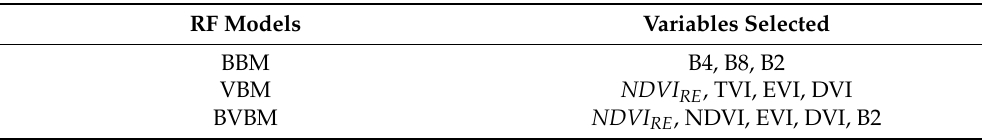
Figure 5. The variables selection of BVBM. ( a , b ) Removes the negatively important variables based on the VI mean and standard deviation, respectively (( a ), the threshold position is represented by a solid red line that runs horizontally, and ( b ), the green segmented line represents the predicted value given by the CART model, and the red line with dashes running horizontally represents the minimum predicted value). ( c ) Gradually builds a random forest from only the most important variables to all variables selected in the first step, and selects the corresponding variables according to the average OOB error (the vertical solid red line indicates the minimum error position). ( d ) Gives the number of variables meeting the requirements. Table 4. The variables selection results using the VSURF